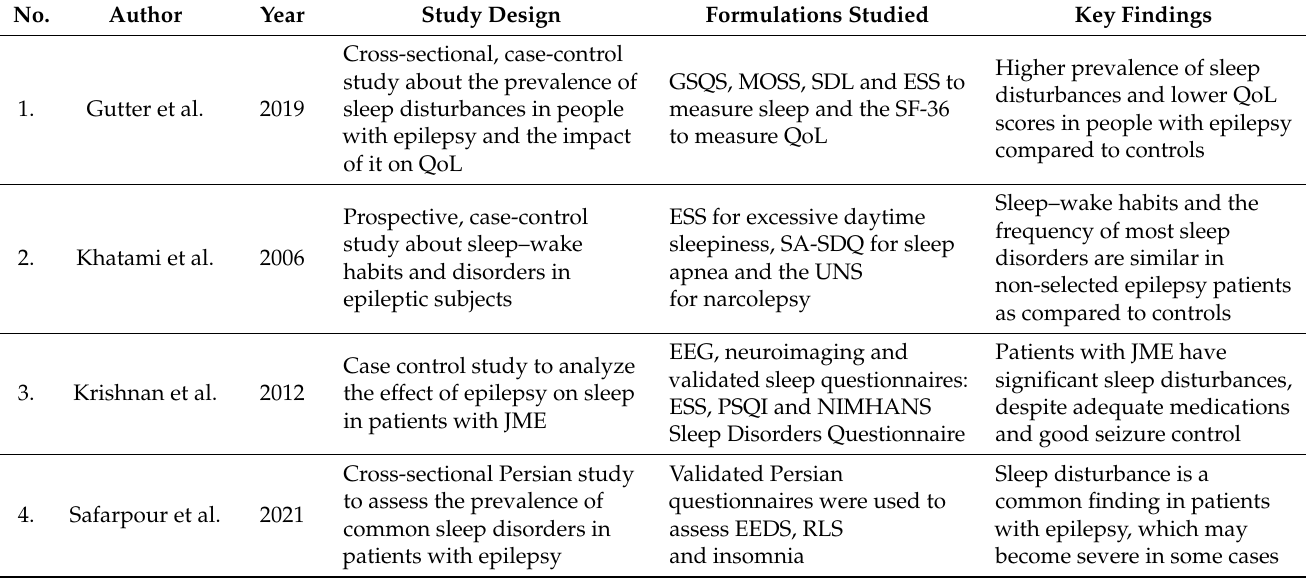
Table 8. A comparison table of clinical studies which investigated the sleep disturbances in